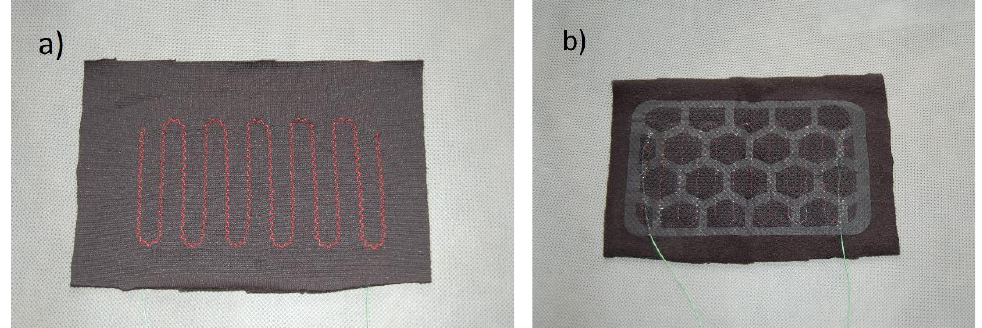
Figure 2. Photographs of the heating insert (variant B) — outer surface ( a ) and inner surface ( b ).